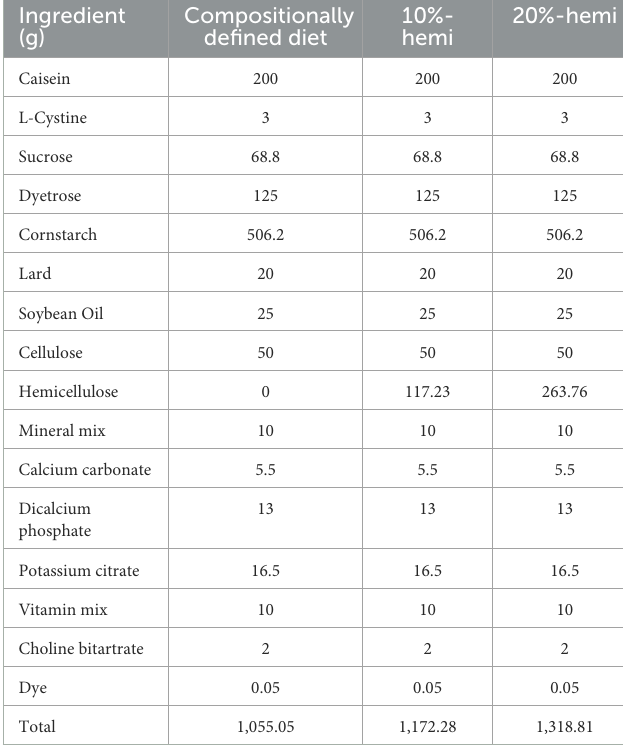
TABLE 1 Composition of the experimental